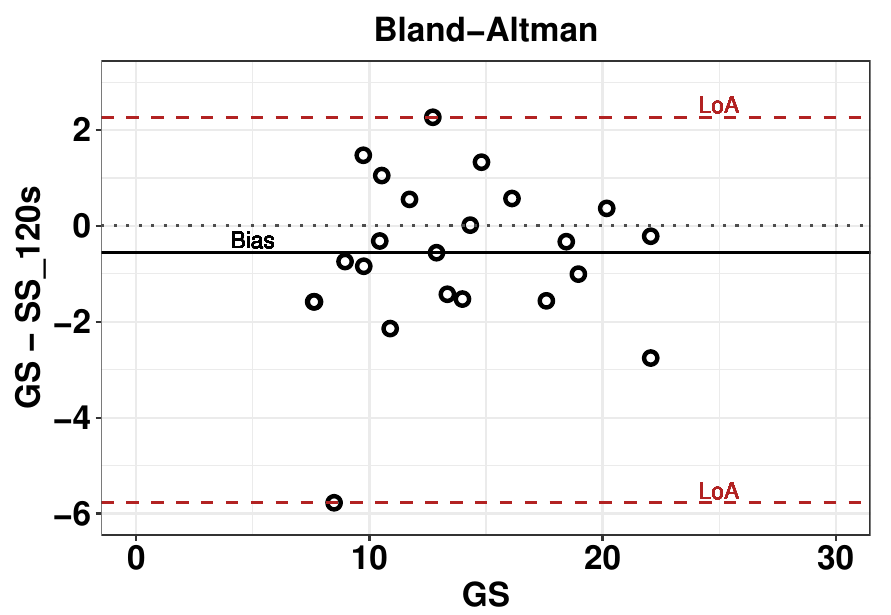
Figure 10: Analysis of the Bland-Altman plot to study the concordance between the GS and the 120 s series of the SS index. short series. An overestimation of GS is observed due to the negative result of the bias. And there is a decrease in the LoA 95% with the temporary increase of the ultra-short